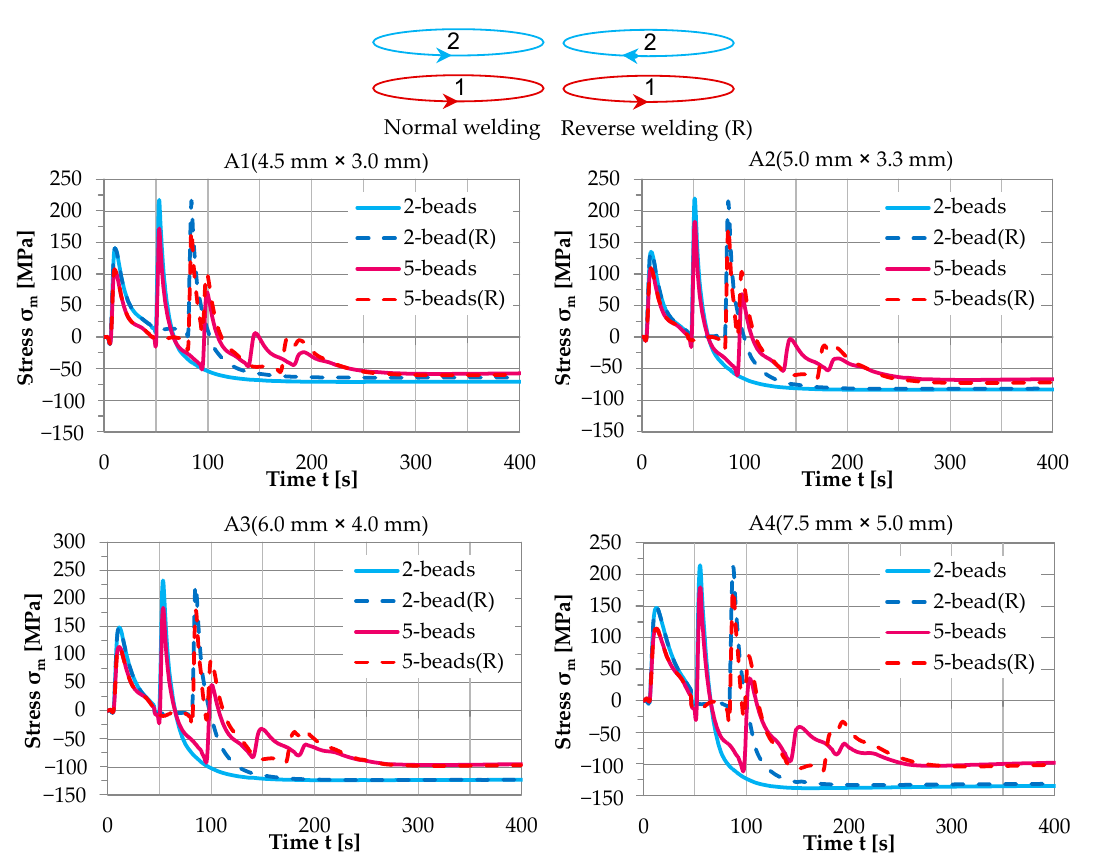
Figure 25. Comparison of stress history of the tool-elements with 2 and 5 parallel beads of dimensions (A1–A4), welded in normal and reversed welding direction (R).